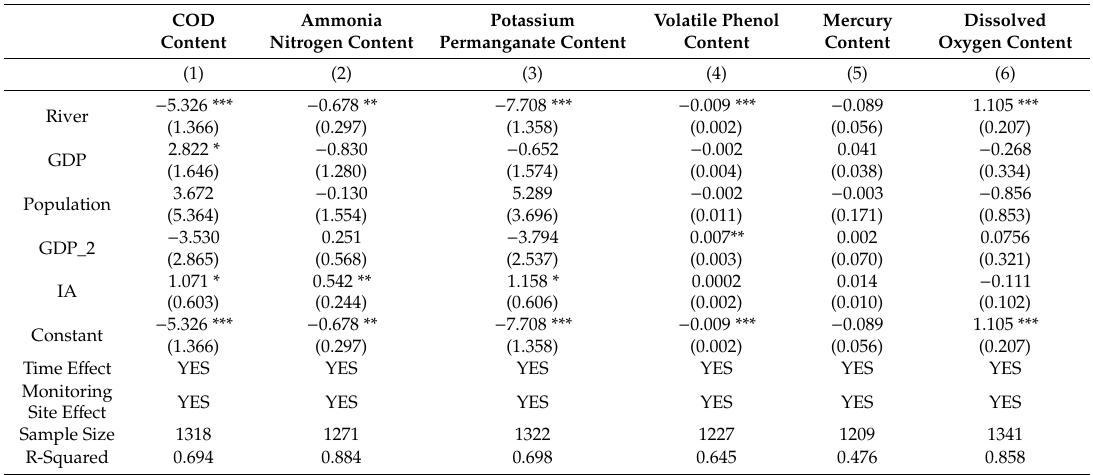
Table 7. E ff ects of the RCS on water quality (data gleaned from state-controlled monitoring